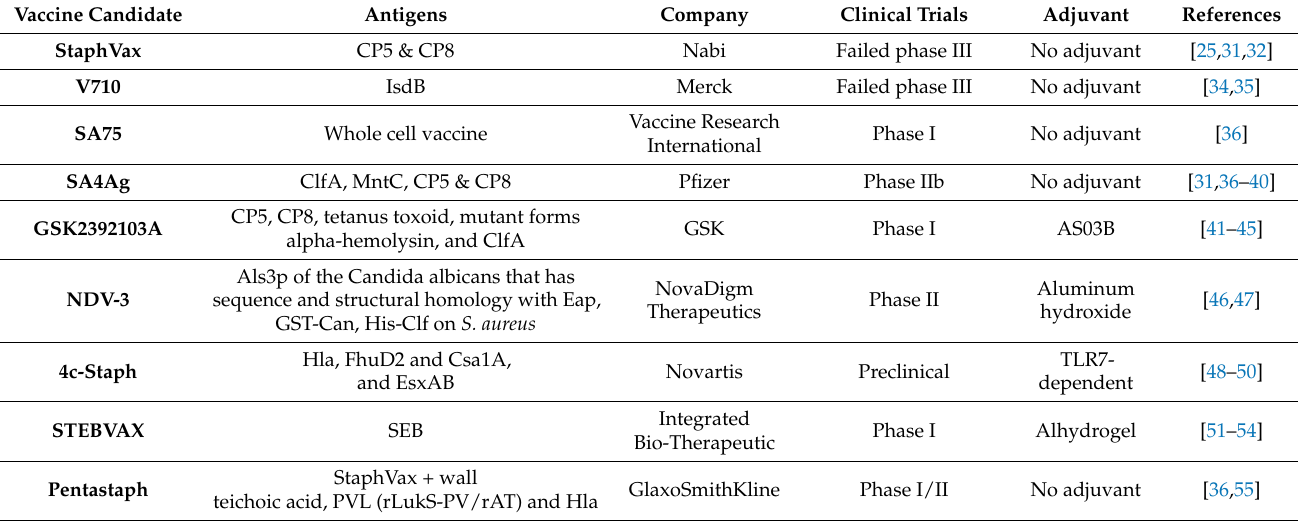
Table 1. Summary of the clinical trials of various vaccine candidate antigens against S. aureus